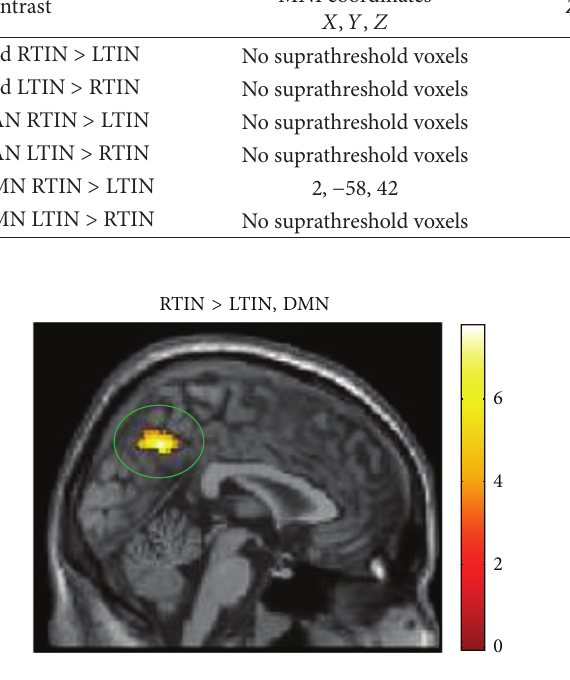
Figure 3: Statistical parametric maps for post hoc independent sample 𝑡 -tests for the resting state analysis of the default mode net- work. Whole-brain post hoc independent sample 𝑡 - tests were used to determine group differences. Statistical tests detected increased response in the right precuneus/posterior cingulate in the RTIN group compared to the LTIN group. For better visualization, the maps are displayed at 𝑝 < 0.001 uncorrected, but the circled cluster is corrected for multiple comparisons ( 𝑝 < 0.025 FWE). DMN: default mode